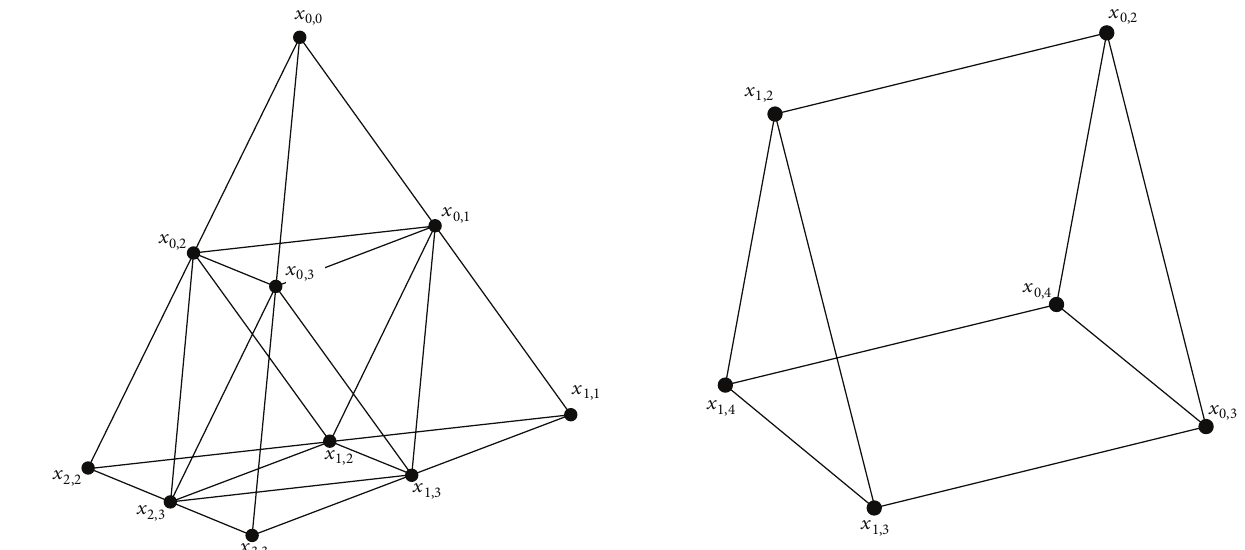
Figure 4: A cell of level 𝑚 − 1 of a graph Γ 𝑚 , approximating P 4 .